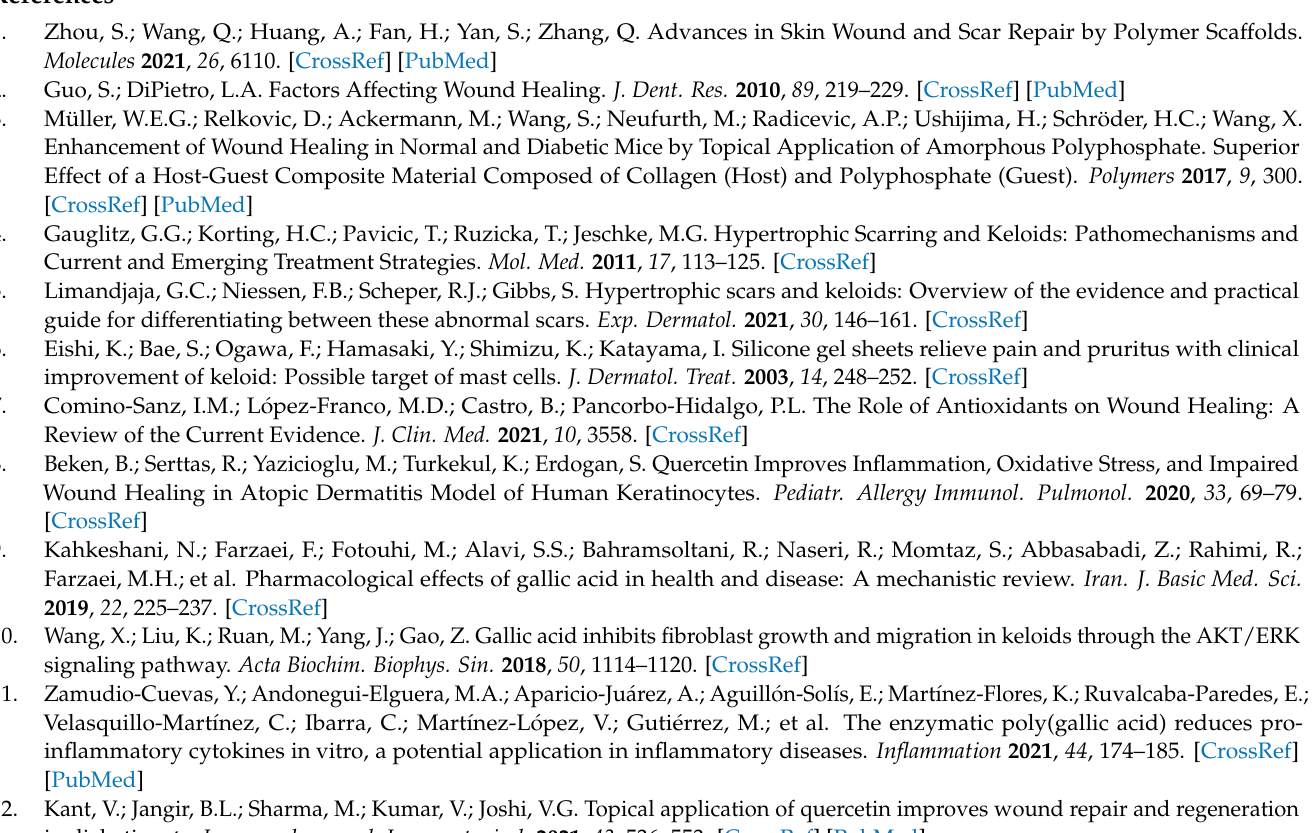
QAGNs; Figure S4. Drug releasing profiles of Qu in QAGNs; Figure S5. (A) Mechanical properties analysis of composite MN patches with various concentrations of gelatin; (B) Insertion in parafilm; Table S1. Primers used in this